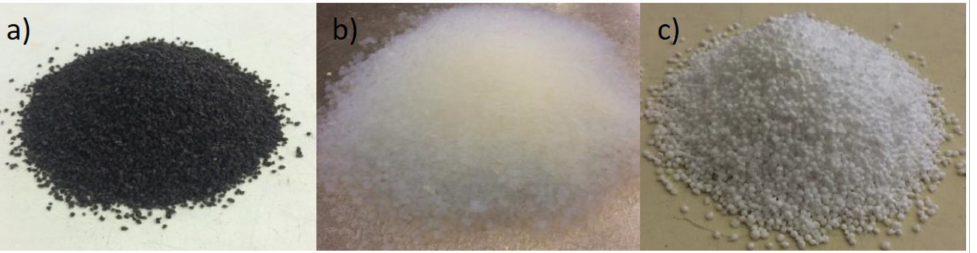
Figure 8. Lightweight aggregates used in the study: ( a ) regranulated expanded cork (GEC); ( b ) hy- drophobic silica aerogel (SA); and ( c ) expanded polystyrene (EPS).